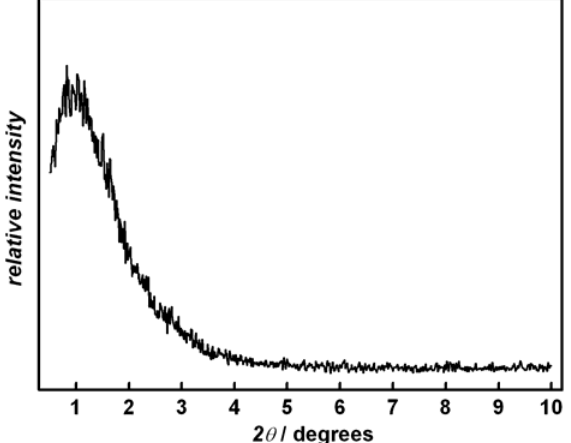
. The broad low-angle reflection 2